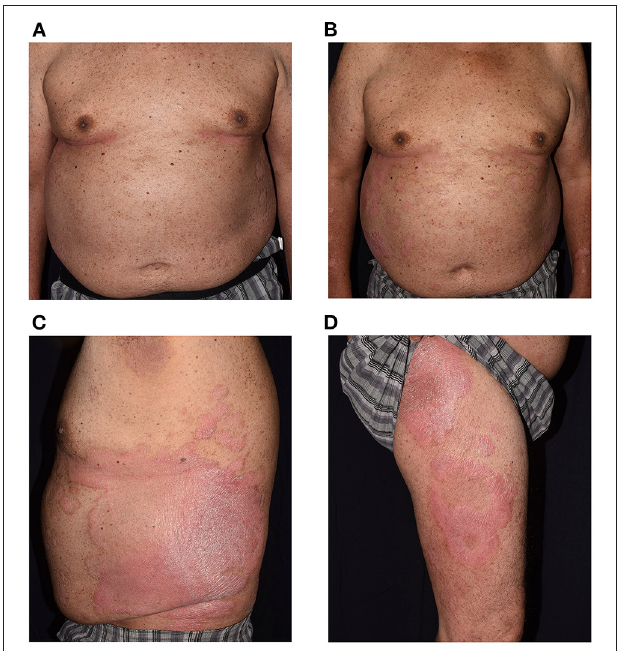
FIGURE 1 | Clinical exacerbation of a 68-year-old man from baseline (A) Psoriasis Area Severity Index (PASI) at 5.4. Extensive erythematous scaly patches developed 14 days after Moderna vaccine, covering more than 13% of total body surface area, with PASI score at 10.0 (B–D) .